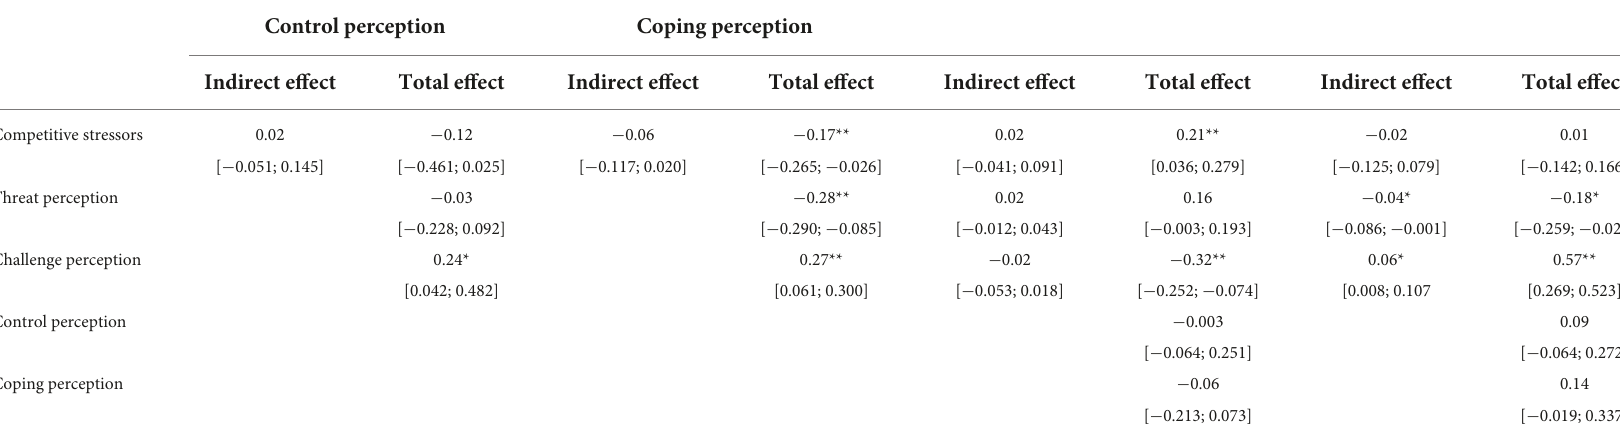
TABLE 3 Indirect and total standardized effects (confidence intervals) of the partial mediation model.